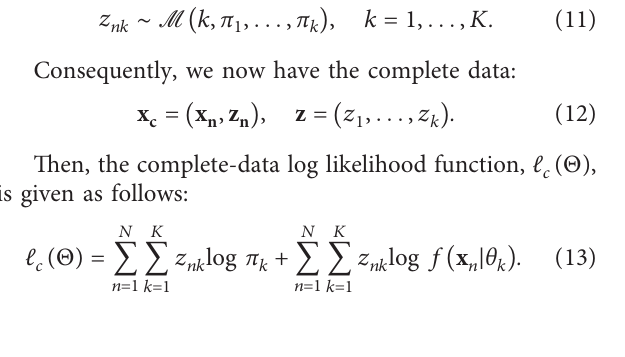
Algorithm 2.1 from Dißmann et al. [17] computes a given